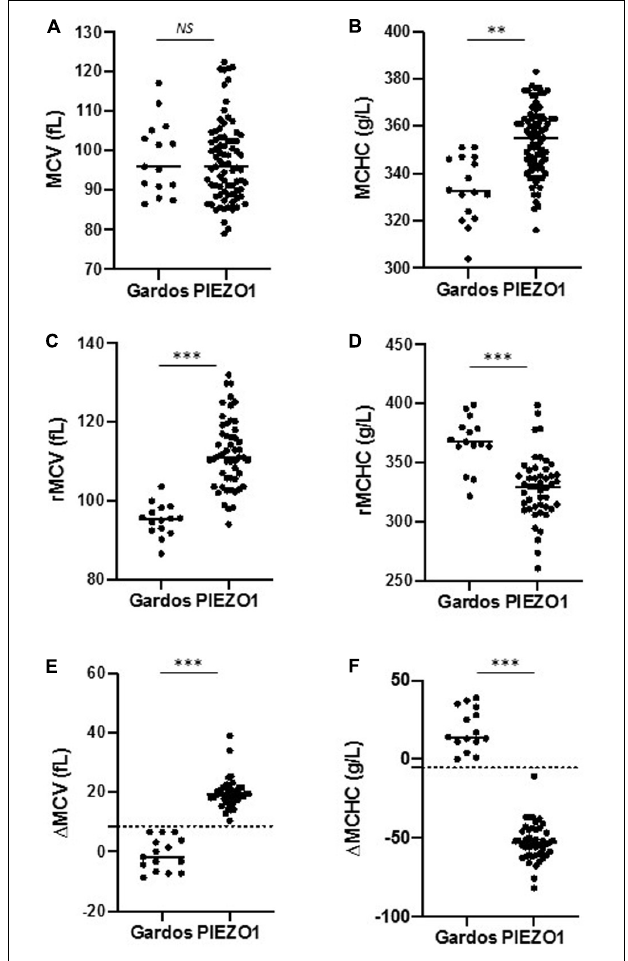
FIGURE 1 | Red cell and reticulocytes indices in Piezo1- and Gardos-HX. (A,B) Comparison of MCV (fL) and MCHC (g/L) of all red blood cells (mature + reticulocytes) in Piezo1-HX ( n = 79) and Gardos-HX ( n = 15). (C,D) Comparison of MCV (fL) and MCHC (g/L) of reticulocytes in Piezo1-HX ( n = 79) and Gardos-HX ( n = 15). (E,F) (cid:49) MCV (rMCV – mMCV) and (cid:49) MCHC (rMCHC – mMCHC) parameters could discriminate between Gardos and Piezo1-HX, with cut-off values of 8.6 fL and –5.5 g/L, respectively (dashed line). NS, non-significant; ∗∗ p < 0.01, ∗∗∗ p < 0.001 as analyzed by Student t test. Normal range: MCV: 80–100 fL, MCHC: 310–360 g/L, rMCV: 92–120 fL, rMCHC: 270–330